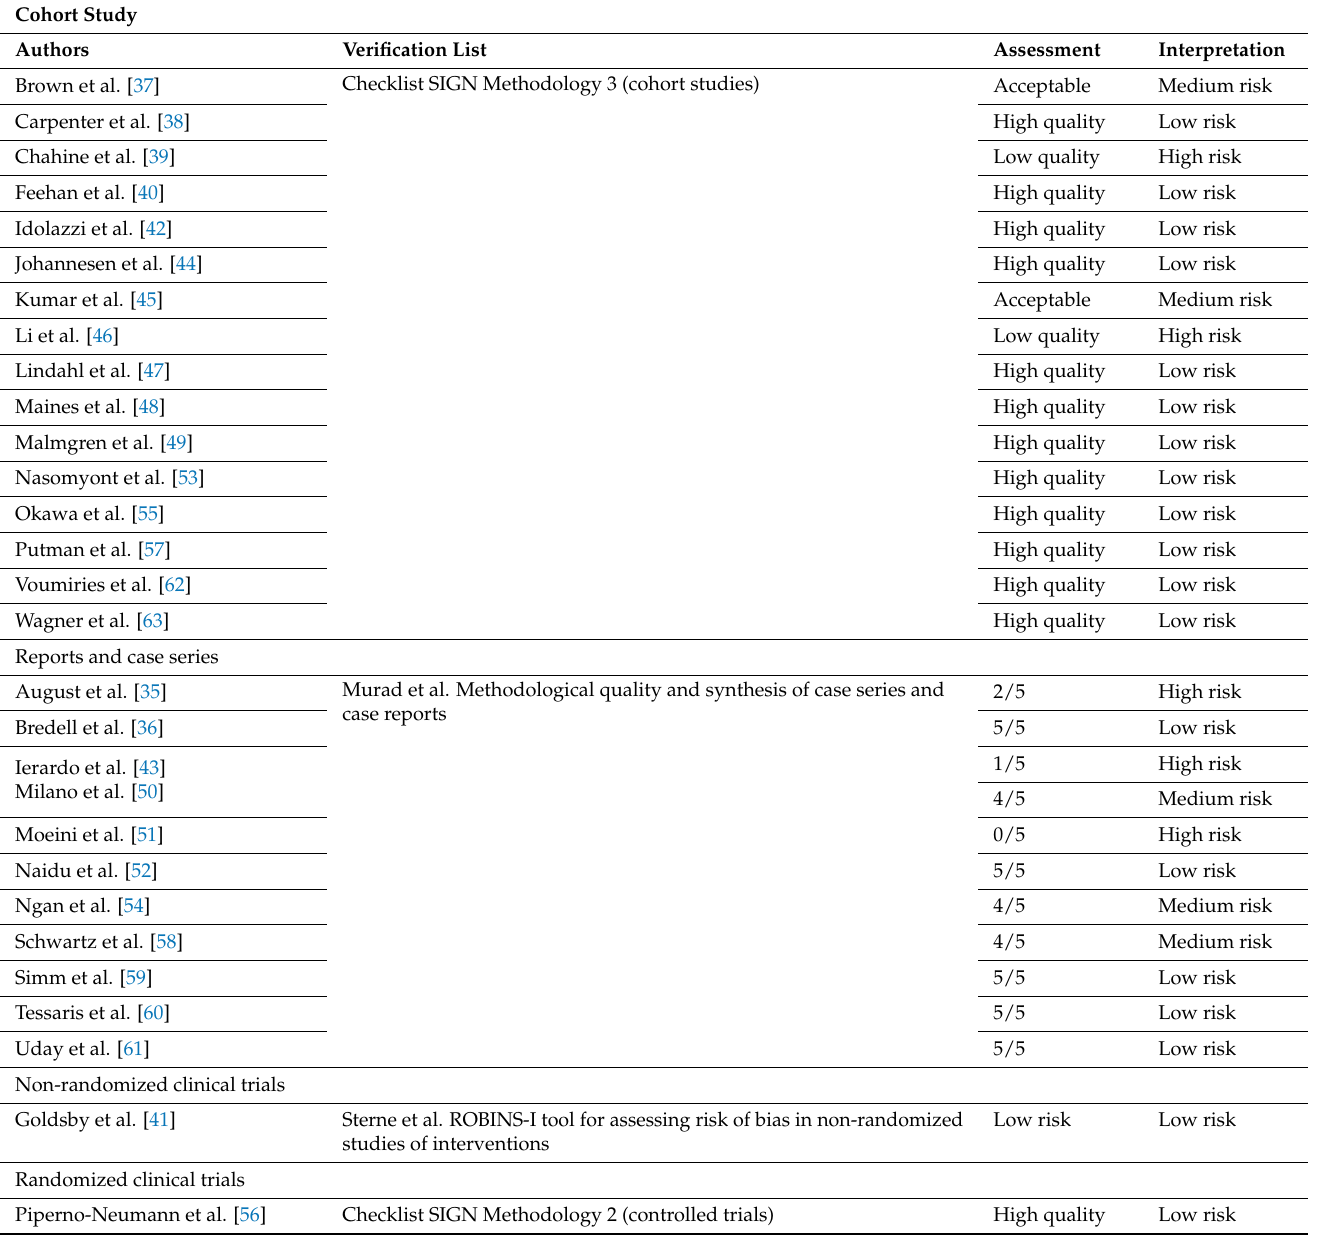
Table 4. Assessment of methodological quality and risk of bias in the 29 articles included in this systematic